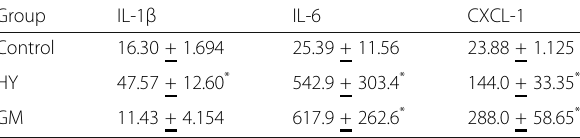
Table 1 Levels of inflammatory mediators following injection of a galactomannan (GM) or Hylan G-F20 (HY) into mouse joints